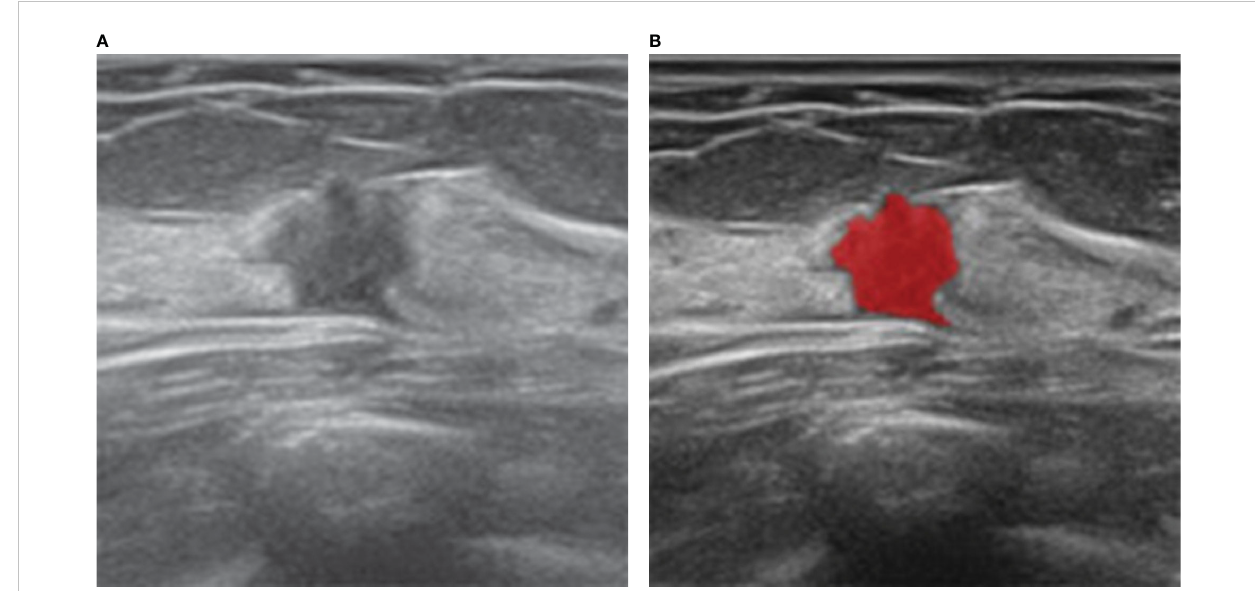
FIGURE 2 Ultrasound and histopathologic fi ndings of a 35-year-old woman with SA. (A) The ultrasound image showed a hypoechoic lesion with irregular shape. The lesion was classi fi ed as BI-RADS 4C and considered malignant, which was considered benign by our model. (B) ROI was manually drawn in red by MaZda software along the edge of the